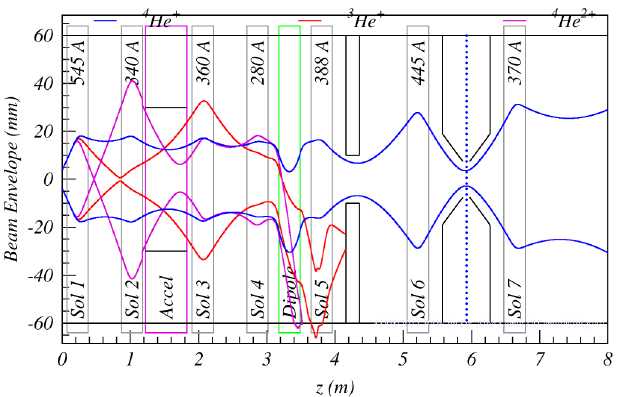
FIG. 11. Horizontal beam envelops for a 4 He þ 50 keV 50 mA, with 1 mA of 3 He þ and 1 mA 4 He 2 þ contaminations (neutral- ization 90%). While the 4 He 2 þ is eliminated in the analyzing magnet chamber, the 3 He þ is stopped by the pumping stage aperture. A similar study has been performed for a H þ 50 keV 100 mA beam with 10 mA of H 2 þ and 1 mA of H 3 þ . In this case both parasitic beams are eliminated at the column entrance, by the analyzing magnet chamber and by the pumping stage aperture.